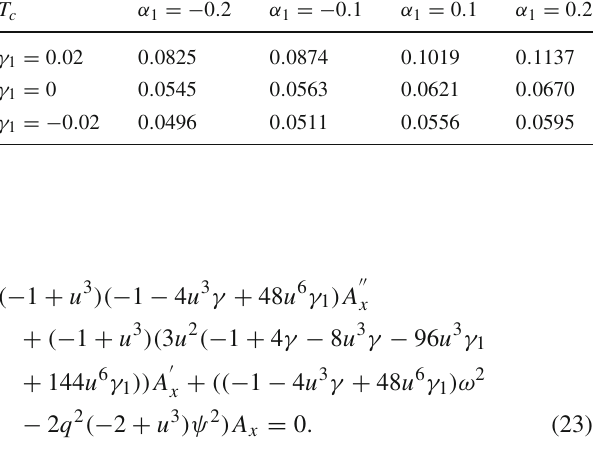
α γ or γ 1 and 1 . Here the mass of scalar field is m